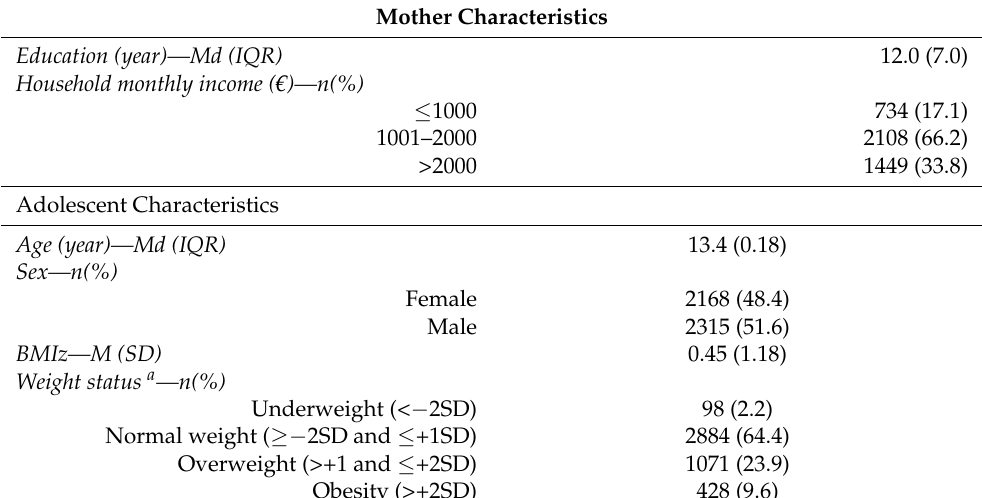
Table 1. Mother and adolescent sociodemographic and anthropometric characteristics at 13 years of age follow-up ( n = 4483).